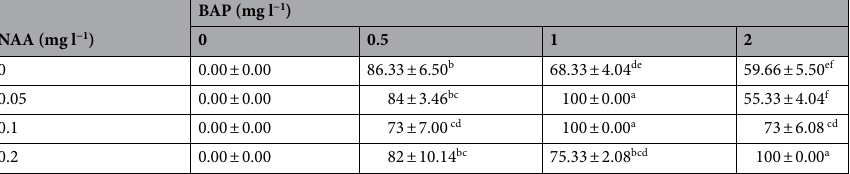
Table 1. Effect of different concentrations of BAP/ NAA on shoot regeneration frequency from cotyledonary nodes of L . iberica . Means with only the same letters are not significantly different at the 5% level based on Duncan’s multiple range test ( p ≤ 0.05). Data shown represent means of regeneration frequency ± SD ( n = 3).